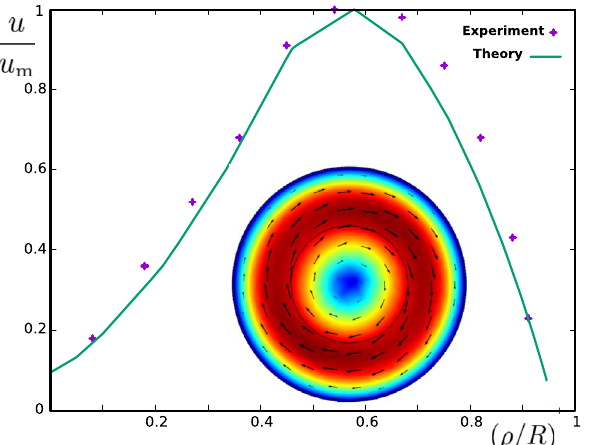
Figure 3. Experimental results (dots) and theoretical results (continuous graph and colored flow pattern) are shown. Speed of the fluid in terms of distance to the center of rotation is plotted. For a fixed distance, the speed is averaged over all angles. Both experimental (dots) and numerical (line) results are scaled by the maximum value of velocity u m . Inset shows a snapshot of numerical solution to the flow equations taking into account the force field obtained from our theoretical results. Arrows show the direction of flow and colors, encode the strength of velocity. Other numerical values are given in the